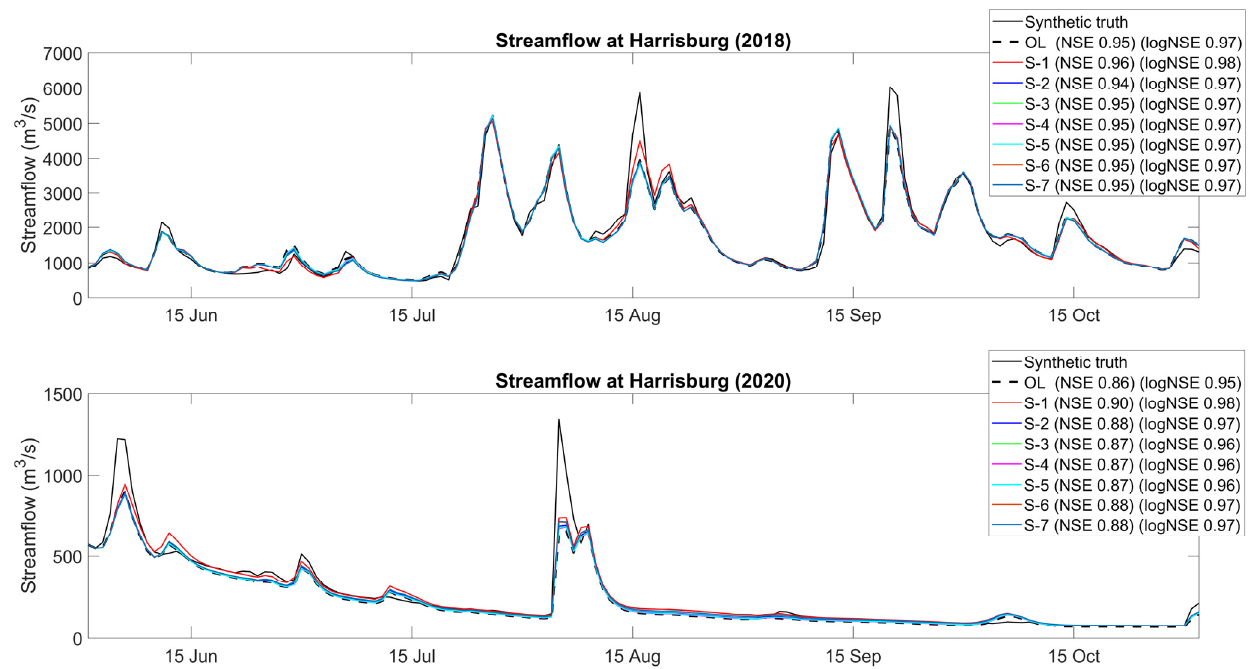
Figure 10. Simulated streamflow at the watershed outlet (Harrisburg) for all seven assimilation scenarios as well as the open loop model run, and synthetic truth model run in 2018 ( top ) and 2020 ( bottom